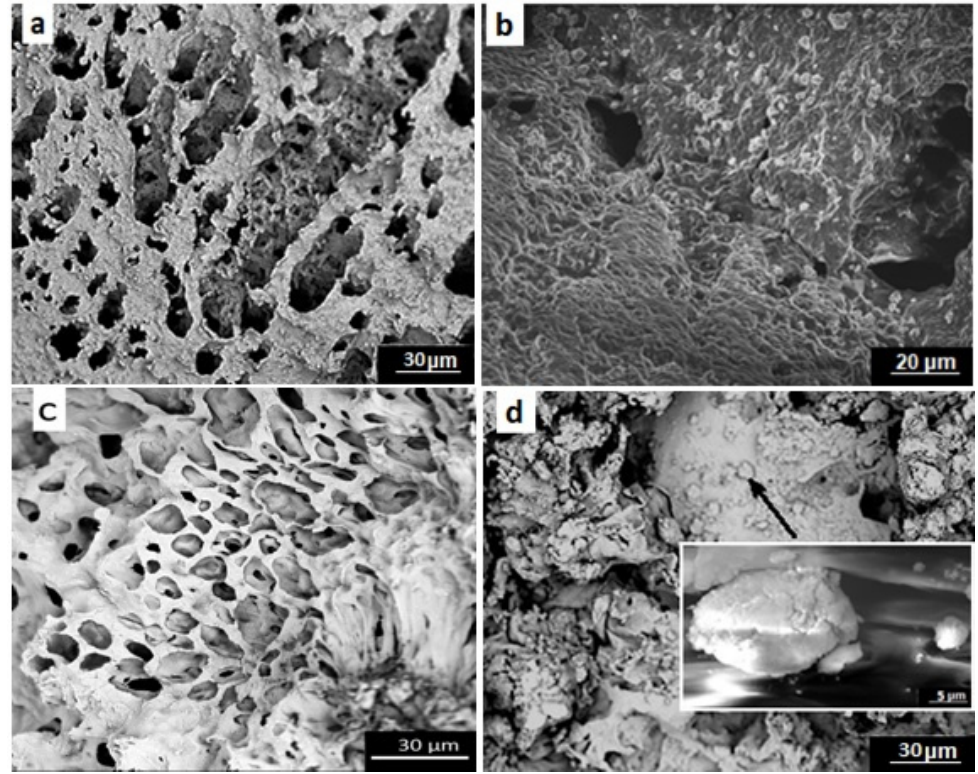
Figure 7. SEM images of ( a , b ) unmodified scaffolds before and after calcification, respectively; ( c , d ) scaffolds modified with gelatin and 5% HAp before and after calcification, respectively.